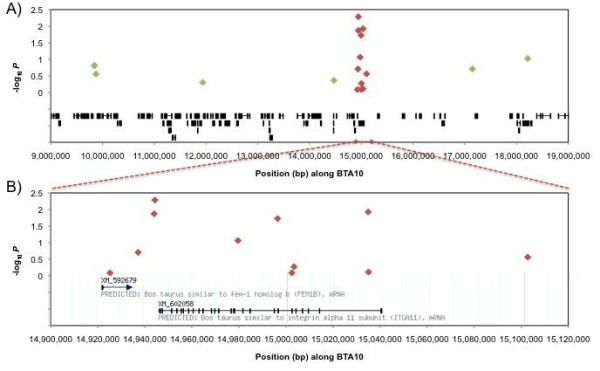
Genetic map of SNP associations with tick burden in the dairy tick sample (DTE). A) Associations with tick burden (-log P) of SNP markers between BTA10:9 Mb - BTA10:19 Mb and B) between BTA10:14.90 Mb - BTA10:15.12 Mb. Markers in green were genotyped only in the DTE sample and markers in red were genotyped in all DTE, BRM and COM samples. The cattle RefSeq mRNA (Btau.4.0) located at the region are displayed at the base of each graph.